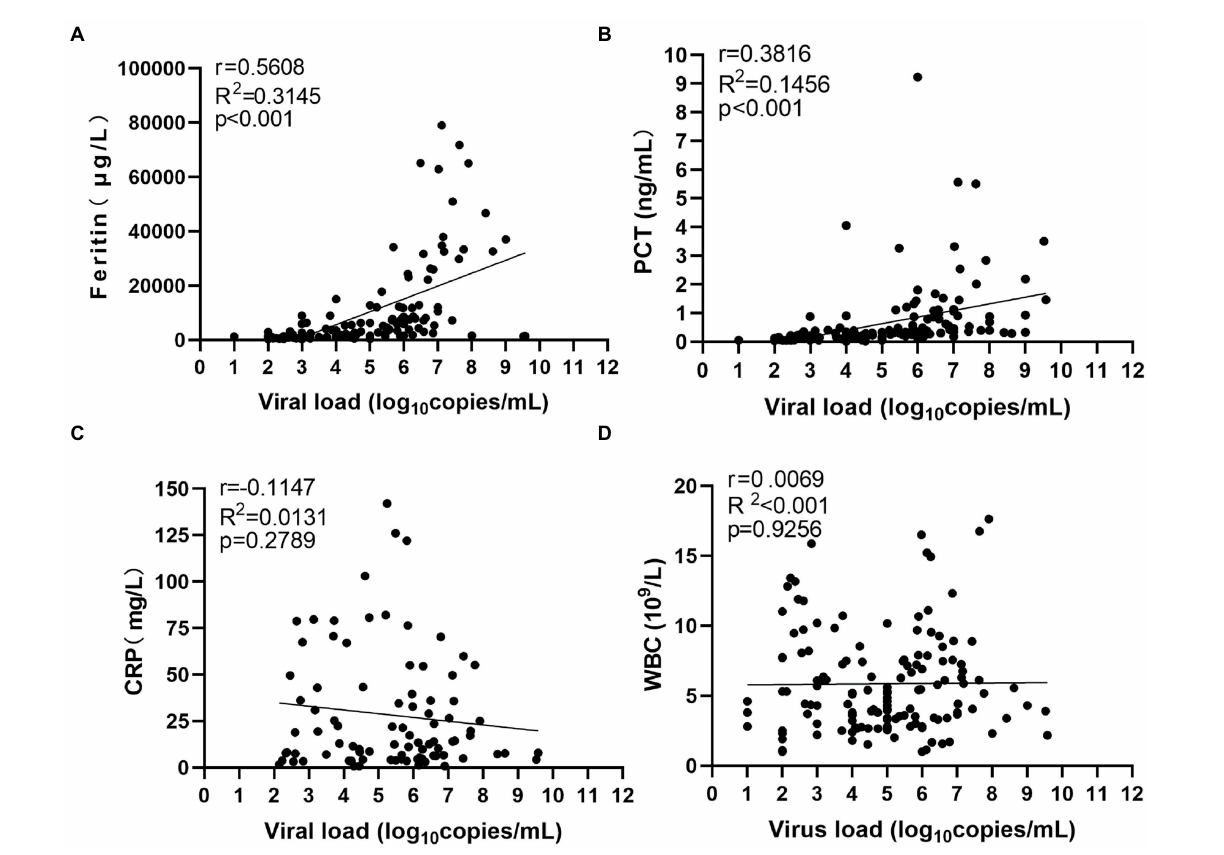
FIGURE 1 Correlation between serum viral load and inflammatory biomarkers. R 2 represents the coefficient of the determination, and r represents the Pearson correlation coefficient, with r values of 0–0.3, 0.3–0.5, and >0.5 indicating weak, moderate, and strong correlation, respectively. p values less than 0.05 were considered statistically